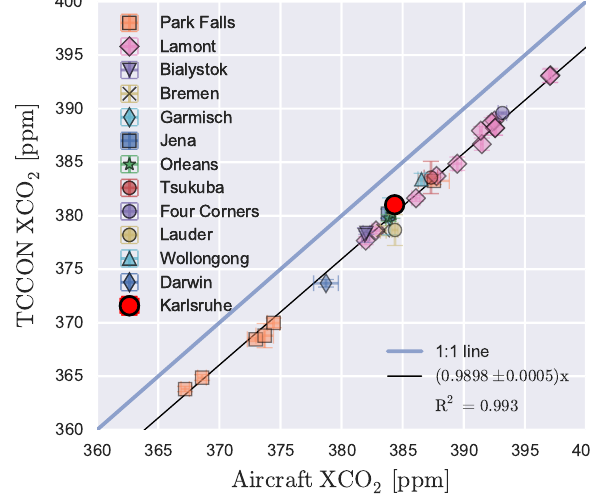
Figure 7. Same as Fig. 6 but using the standard GGG2014 TCCON retrieval strategy for Karlsruhe